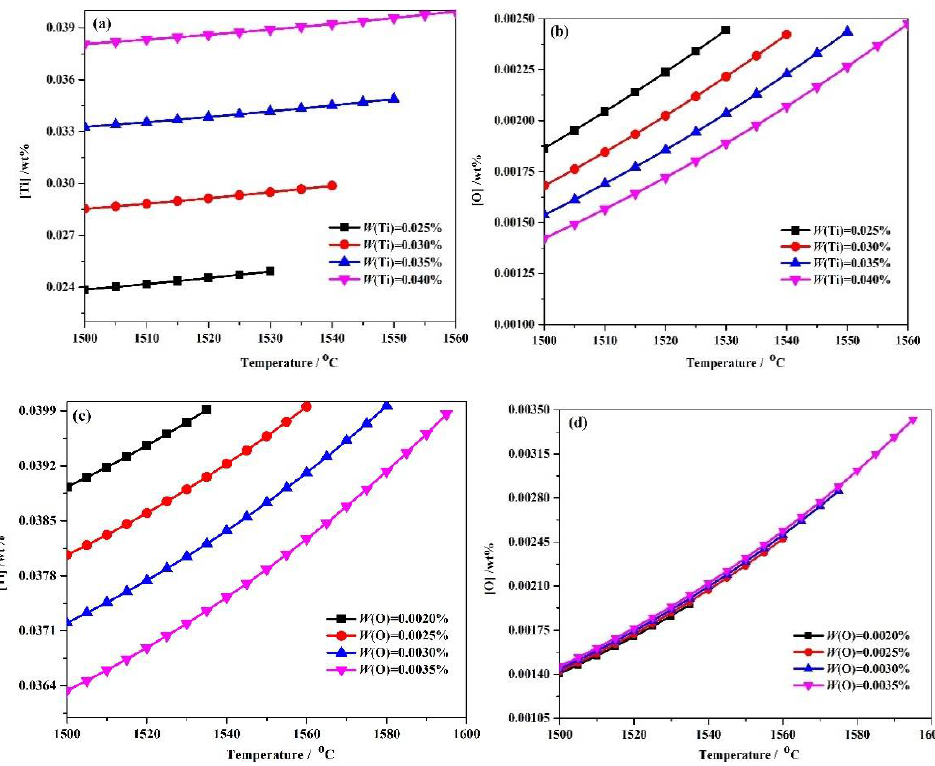
Figure 2. The evolution of ( a , c ) [Ti], wt % and ( b , d ) [O], wt % in molten steel as a function of steel composition and temperature(in °C) in different Ti-O system obtained by thermodynamic analysis.